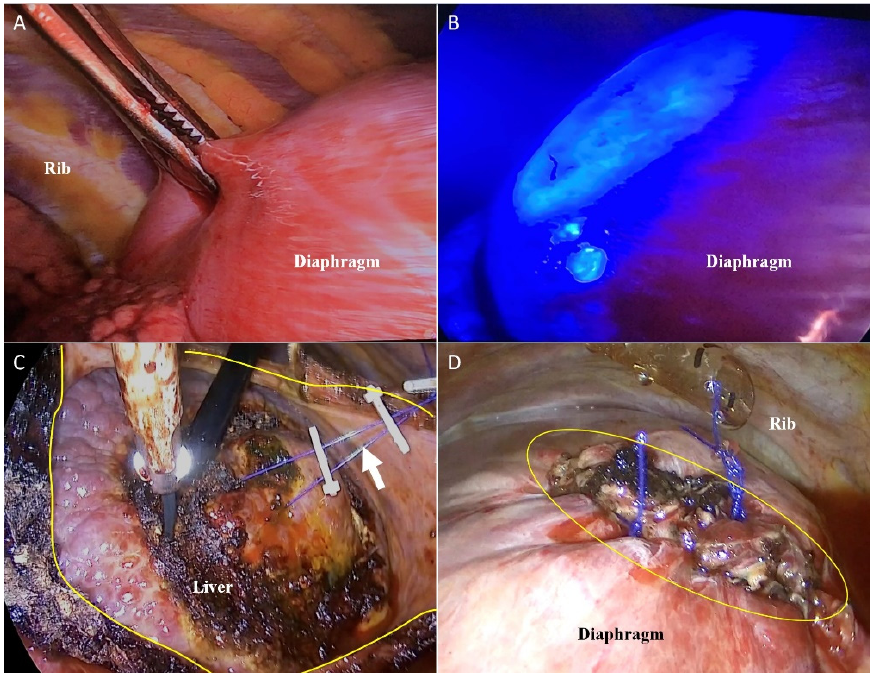
Figure 5. Video-assisted transthoracic liver resection ( A ) Without blue light, there were no indications of tumor location on thoracoscopic view. ( B ) Tumor fluorescence from segment 7 was illuminated through the diaphragm. ( C ) The tumor-bearing region was resected using ultrasonic energy shears (yellow line: incision line on the diaphragm; white arrow: tenting suture). ( D ) The incised diaphragm was closed using non-absorbable suture materials.